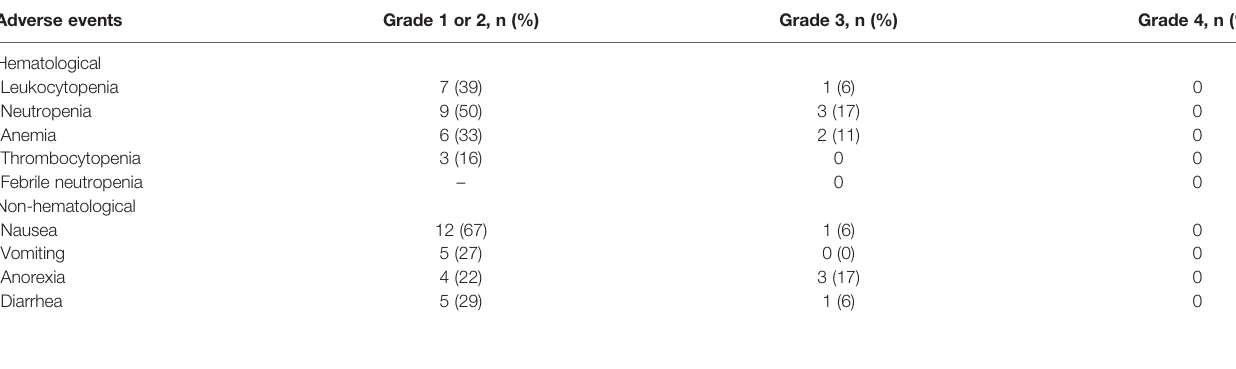
TABLE 4 | Treatment-related hematological and non-hematological adverse events. Adverse events